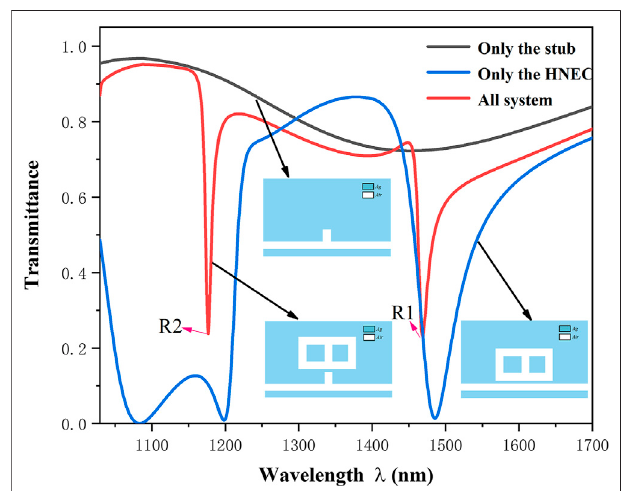
FIGURE 2 | Transmission spectra of the waveguide with the HNEC resonator(blueline),waveguidewithstubresonator(blackline),andprototype structure (red